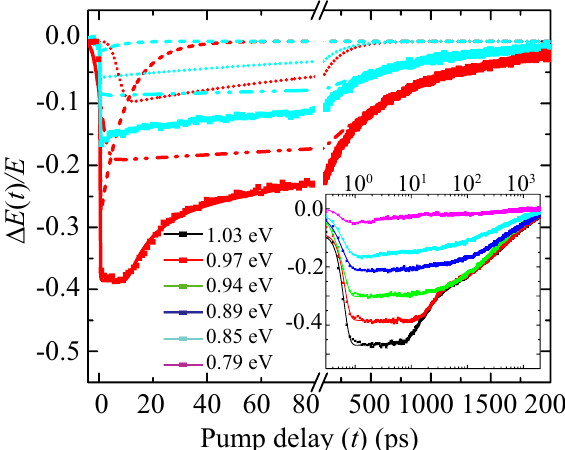
Figure 2. Transient differential THz-electric field [ � E ( t )/ E ] through the MQW sample at 4 K for the excitation photon energies of 0.85 eV (cyan) and 0.97 eV (red). Multi-exponential fits are shown as solid lines, comprised of a fast (dash line), intermediate (dotted line) and slow (dash dot-dot line) component. The insets show a semi- log plot of the transient data and respective fits in the range 0.79–1.03